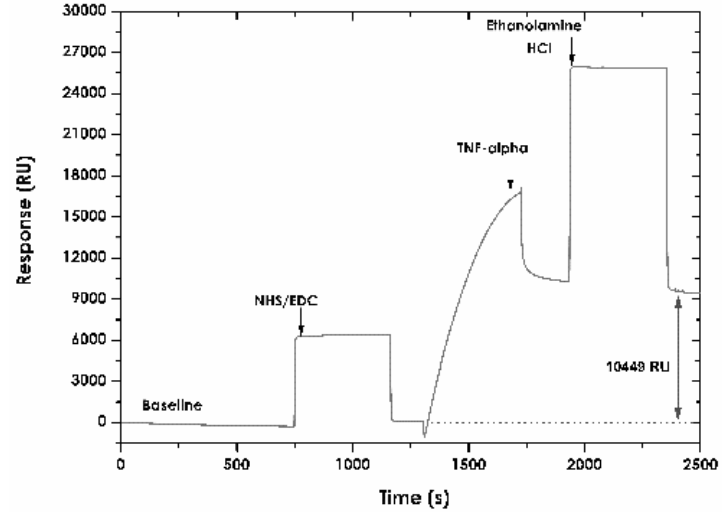
Figure 3. Immobilising TNF- α protein by covalent amine coupling onto the CMD 200 chip. The sensorgram shows TNF- α used as ligand, with its characteristic parts: surface activation (NHS/EDC), ligand attraction and covalent coupling, blocking unoccupied sites (ethanolamine HCl) and final immobilisation response (10,449 RU).